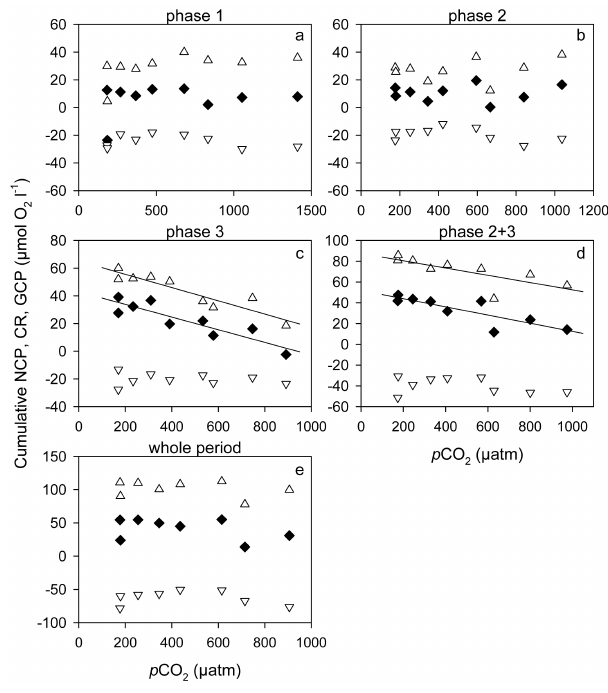
Fig. 2. Relationship between cumulative GCP (open upside trian- gle), NCP (filled diamond), and CR (open downside triangle) (µmol O 2 L − 1 ) vs. the mean p CO 2 (µatm) during (a) phase 1 (end of CO 2 manipulation until nutrient addition: t 4 to t 13), (b) phase 2 (nu- trient addition until the second chlorophyll minimum: t 14 to t 21), (c) phase 3 (the second chlorophyll minimum until the end of this study: t 22 to t 28), (d) phase 2 + 3 (after nutrient addition: t 14 to t 28), and (e) the whole period ( t 4 to t 28). The lines indicate statis- tically significant relationship (F-test ,P <